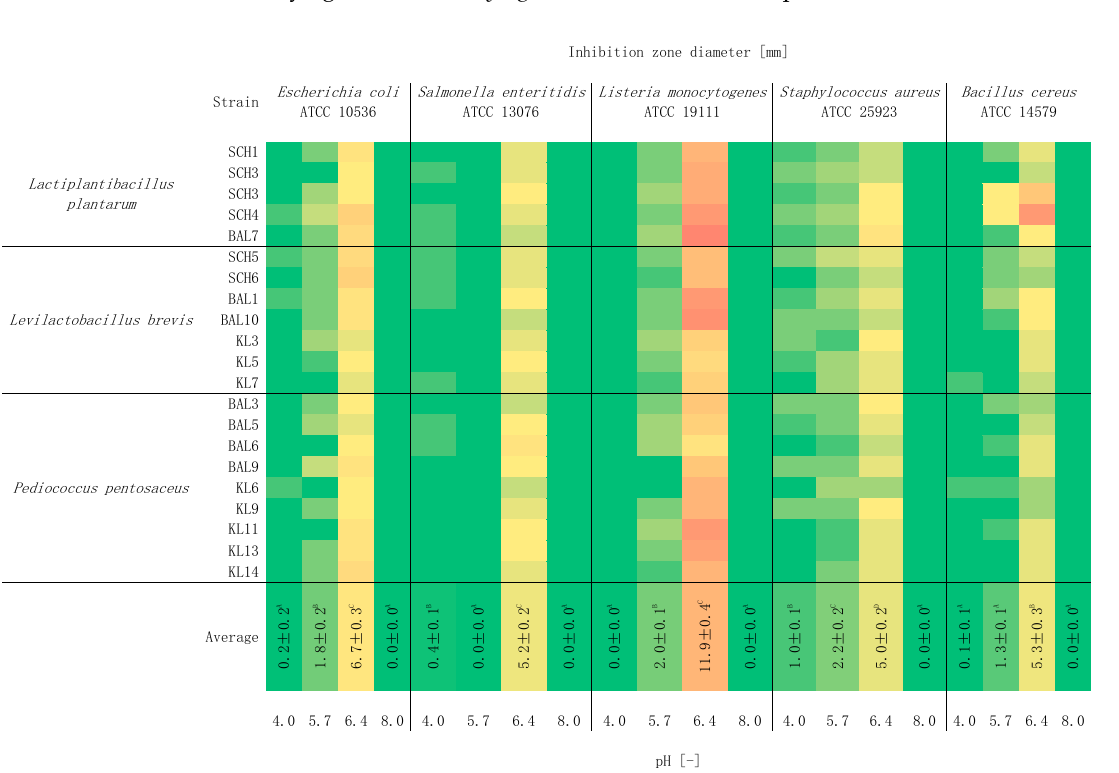
Figure 3. Heatmap about the influence of pH on the antimicrobial activity of LAB strains and against indicator bacteria ( n = 3). Means in the same column followed by different letters (A–D) represent significant differences ( p < 0.05) for each temperature and indicator bacteria.